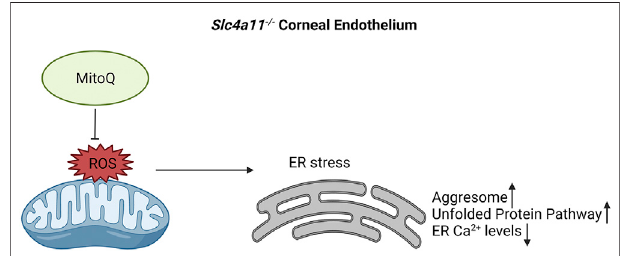
FIGURE 7 | Proposed mechanism for ER stress in Slc4a11 − / − corneal endothelium. Elevated mitochondrial ROS leads to ER stress. This results in decreased ER Ca2+ levels, elevated levels of aggresomes and increase in Unfolded Protein Pathway. Use of mitochondrial ROS quencher, MitoQ, alleviates ER stress in Slc4a11 − / − corneal